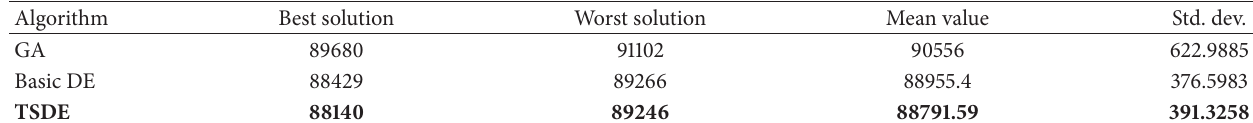
Table 6: Comparison of the best solutions of STDE with basic DE and GA (¥).